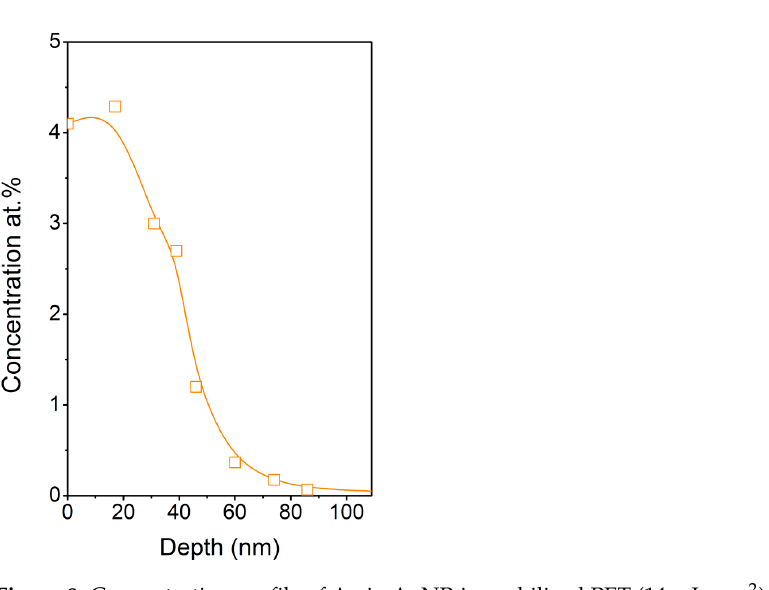
Figure 7. TEM micrographs of cross sections of AgNP-immobilized PET: ( a ) smooth PET and ( b ) corrugated PET surface. In both micrographs and insets, the polymer phase is on top and embedding epoxy resin is at the bottom of the image. Real width of both insets is 1.68 µ m.